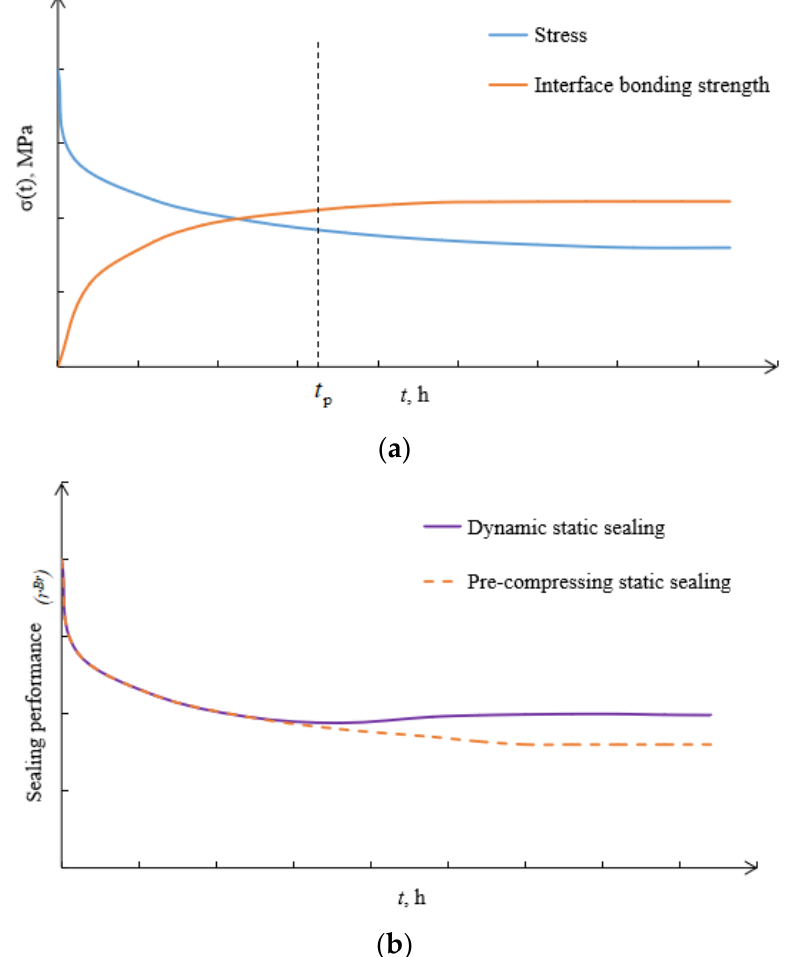
Figure 11. Schematics of the mathematical model of alterable static sealing: ( a ) the stress relaxation behavior (blue) and the interface bonding strength of the interpenetration region around the interface (orange); ( b ) sealing performance ( r B r ) of alterable static sealing (purple) and pre-compressing static sealing (orange).